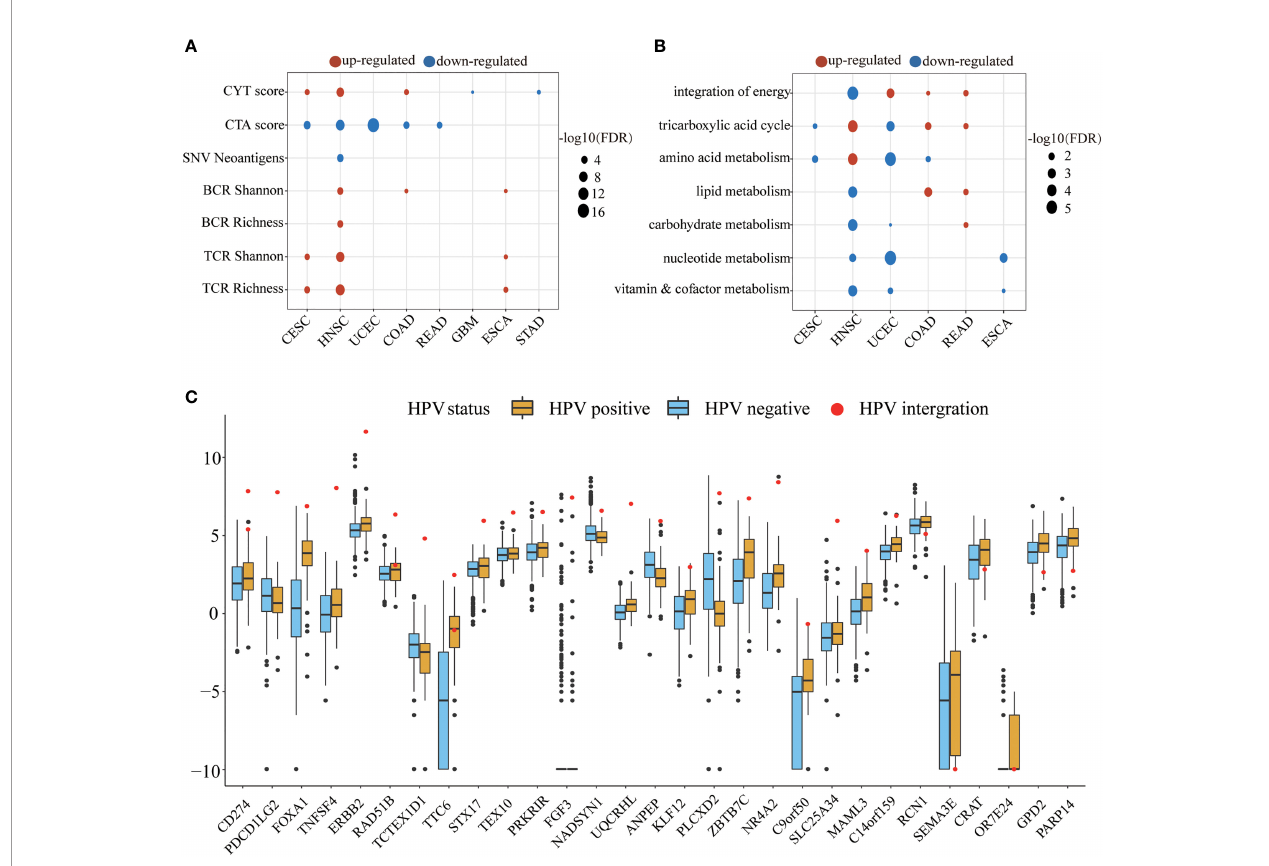
FIGURE 4 | The HPV impact on the tumor microenvironment. (A, B) show the signi fi cant changes in immune indicators and metabolic pathway activity, respectively. The size of bubble represents FDR, and the color represents upregulation or downregulation. All the p values of the non-parametric test have been corrected by FDR. (C) The fi gure shows signi fi cantly different expression of HPV-integrated protein-coding genes between the HPV-positive group (yellow) and the HPV-negative group (blue). The red dots in the box diagram are the expression of HPV-integrated genes in